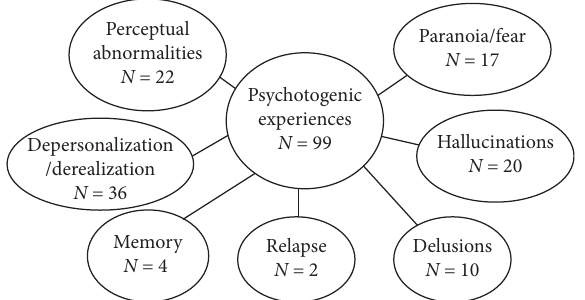
Figure 1: A diagram depicting the subthemes extracted from the analysis, where N is the number of